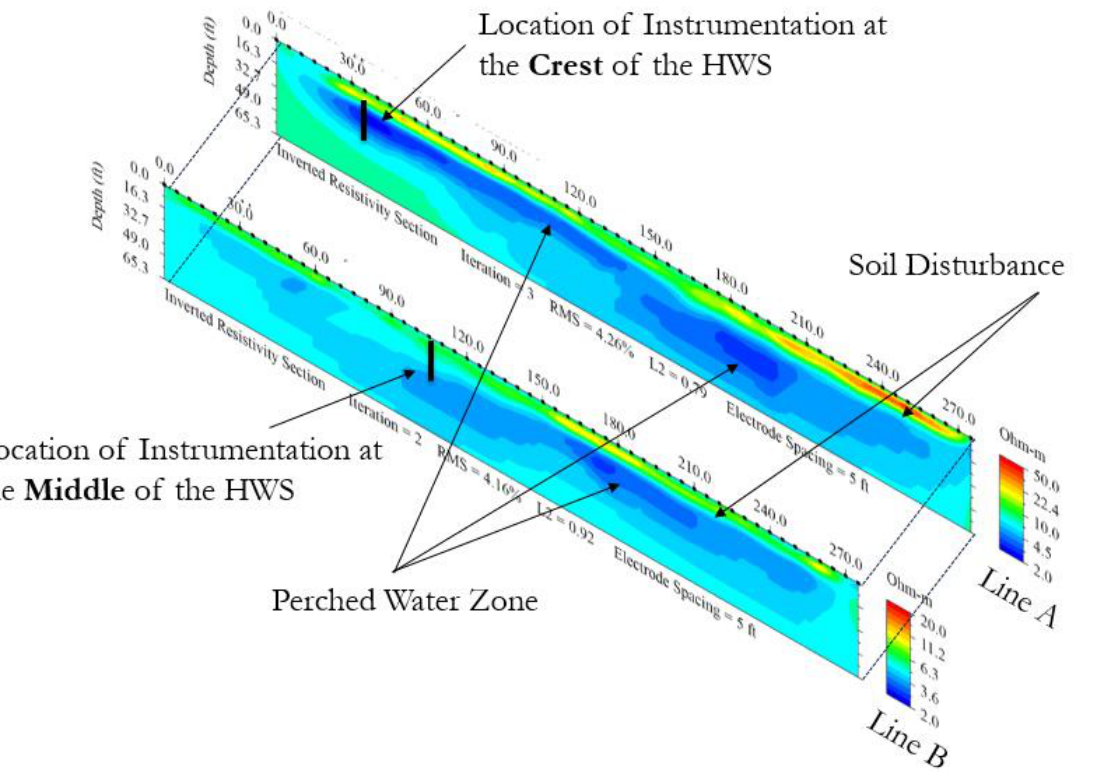
Figure 10. HWS 1, 2D ERI test profile at line A and line B tested on 5 January 2021 (1 ft = 0.3 m).